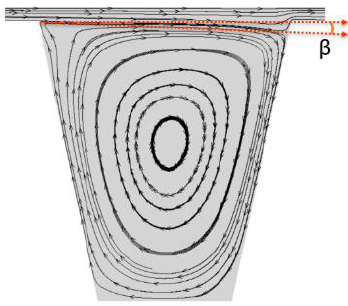
Figure 3. The divergence angle of the jet.